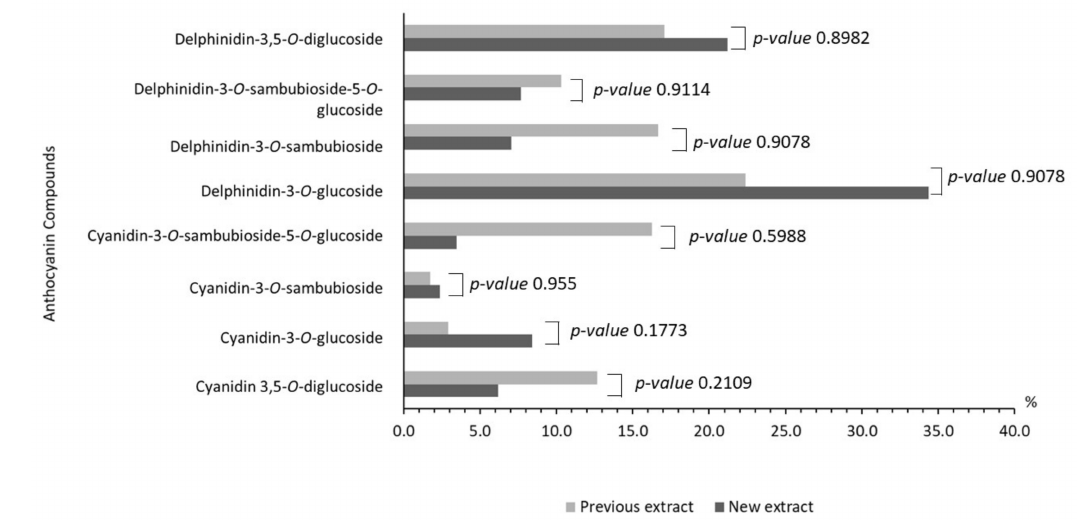
Figure 2. Determination of individual anthocyanin compounds in maqui extract by ultra-high-performance liquid chro- matography (UHPLC-MS/MS) Orbitrap. Our data (new extract; dark gray) are presented according to the percentage of anthocyanin compound and compared with the anthocyanins profile previously reported (previous extract; light gray)